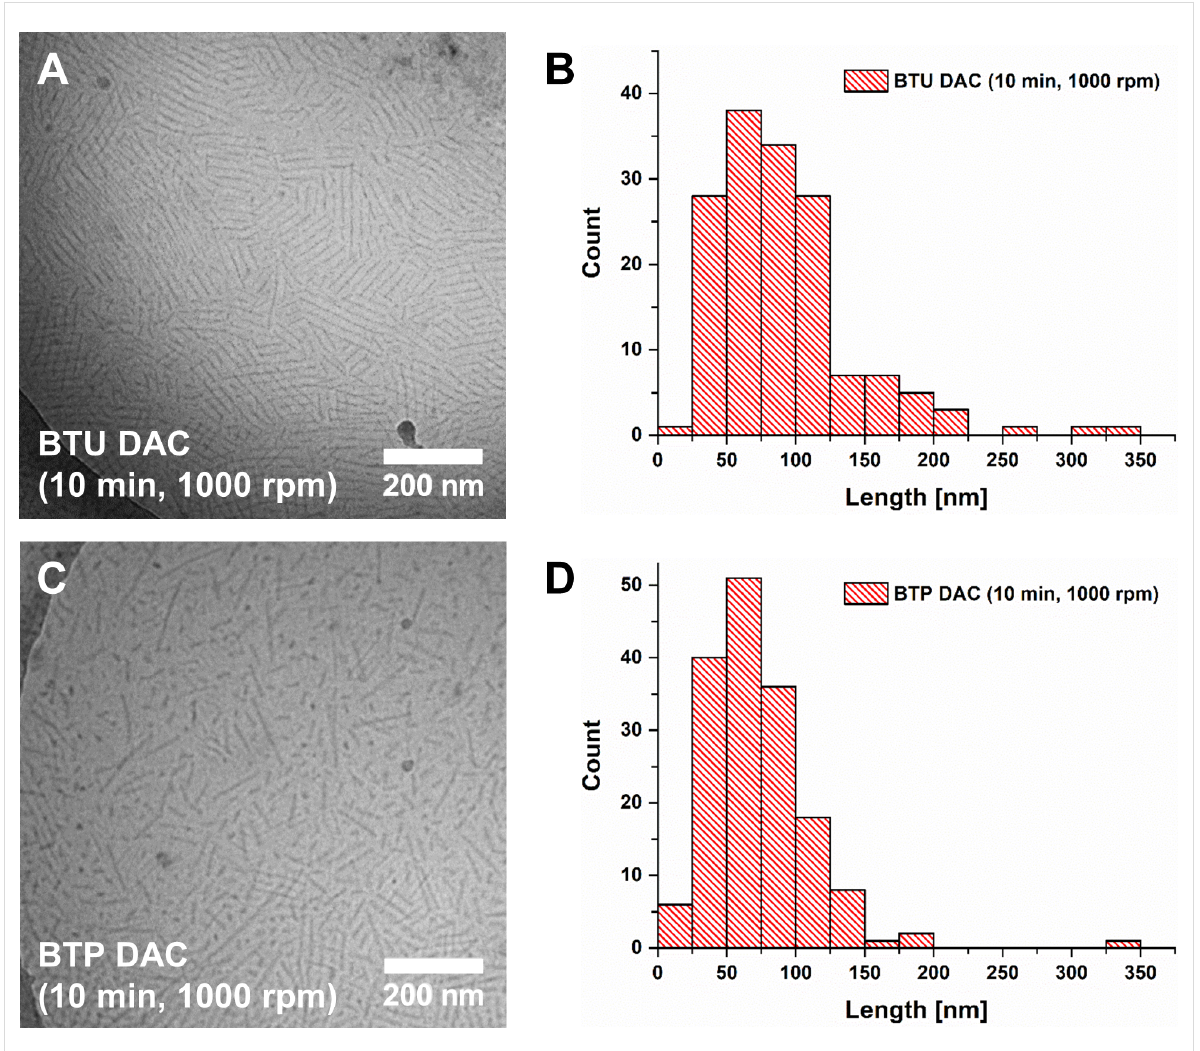
Figure 2: cryoTEM images of A) BTU DAC (10 min, 1,000 rpm) and C) BTP DAC (10 min, 1,000 rpm). The corresponding histograms B) and D) show the length distribution of BTU DAC (10 min, 1,000 rpm, B, mean length: 92 ± 51 nm) and BTP DAC (10 min, 1,000 rpm, D, mean length: 74 ± 39